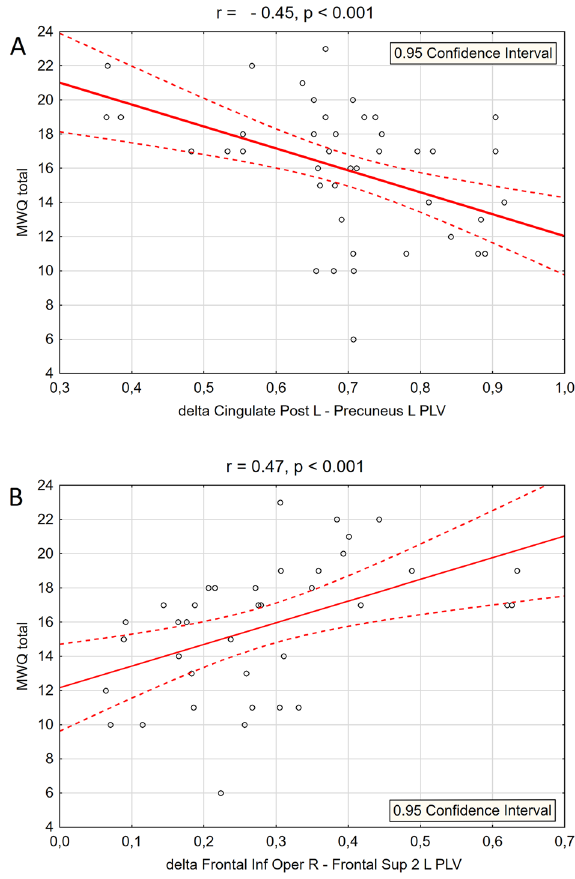
positive correlations between MWQ and inter-networks connectivity covering structures belonging to the CON and FPN network in delta